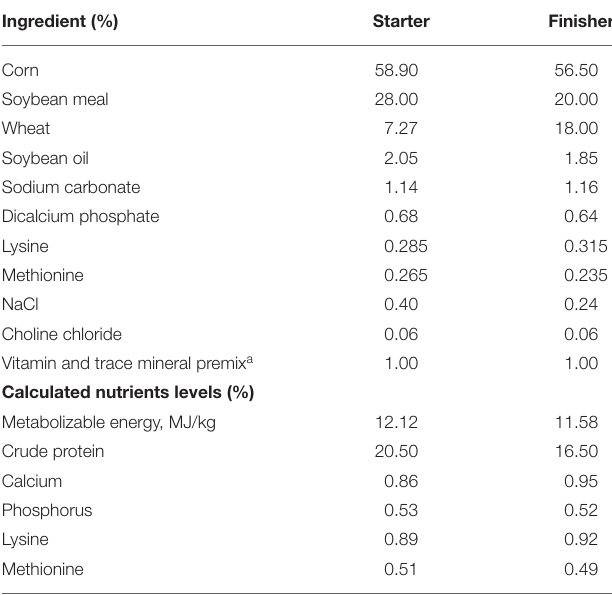
TABLE 1 | Composition and nutrient levels of